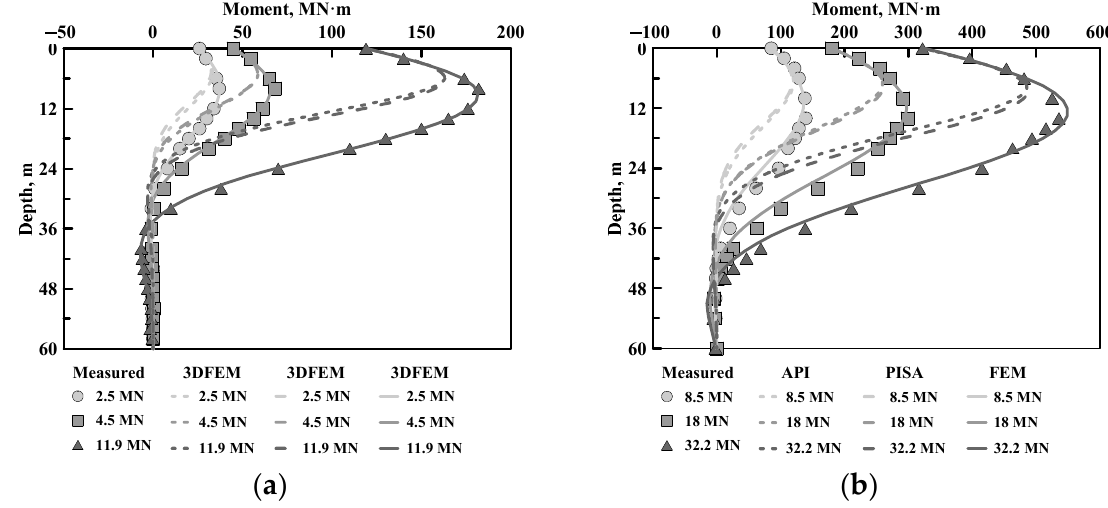
Figure 5. Comparison of measure and computed bending moment profiles of centrifuge tests: ( a ) D = 4 m, ( b ) D = 6 m.